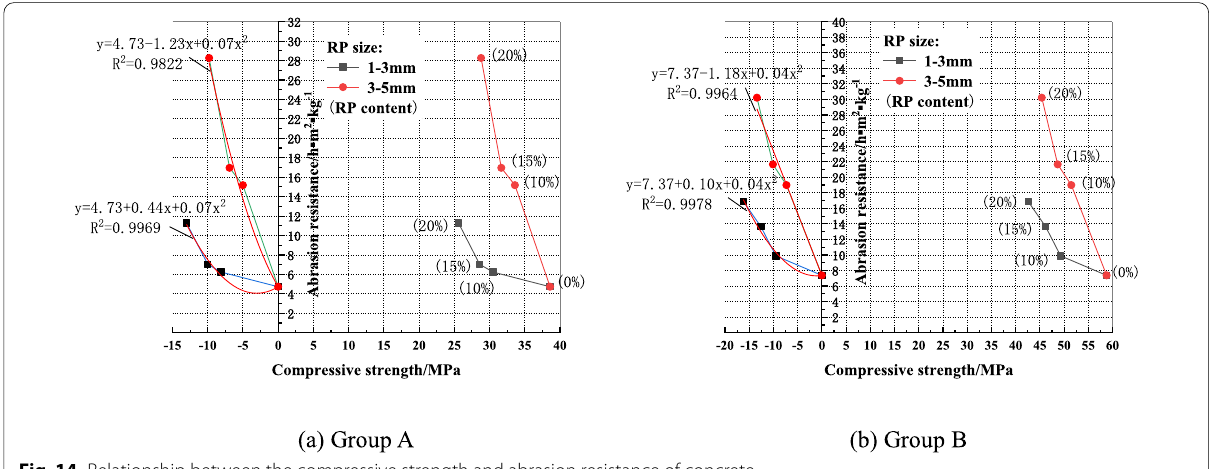
Fig. 14 Relationship between the compressive strength and abrasion resistance of